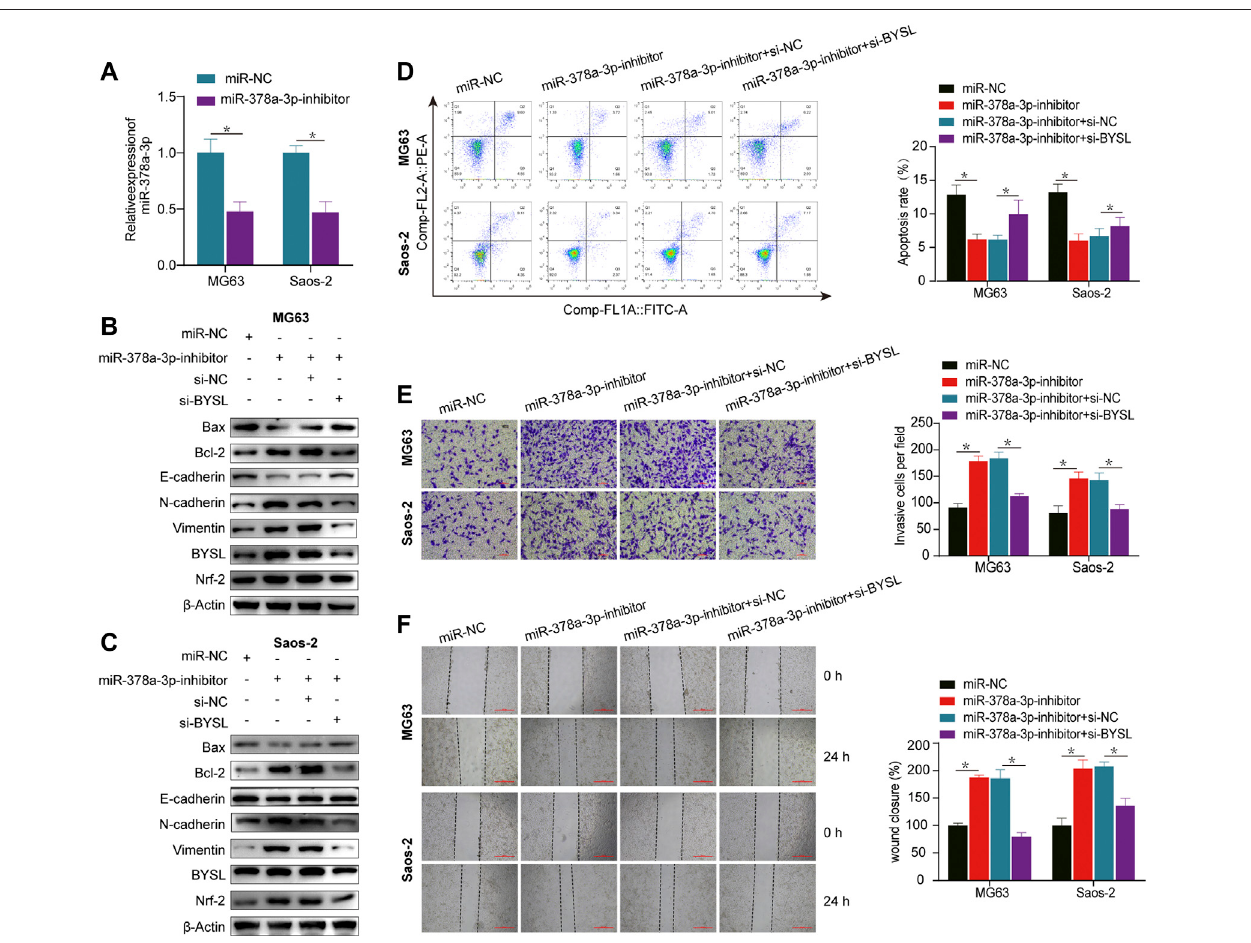
FIGURE 3 | BYSL knockdown partially abolishes miR-378a-3p-mediated osteosarcoma cell epithelial-to-mesenchymal transition (EMT), invasion, migration, and apoptosis under normoxia. (A) MG63 and Saos-2 cells were transfected with control-inhibitor (miR-NC) or miR-378a-3p-inhibitor, and then cultured under normoxic conditions. The RNA level of miR-378a-3p was measured by RT-qPCR. (B,C) MG63 and Saos-2 cells were transfected with control-inhibitor (miR-NC), miR-378a-3p- inhibitor,si-control(si-NC),orsi-BYSL, andthencultured undernormoxicconditions.Theproteinlevels ofBax,Bcl-2,E-cadherin,N-cadherin, vimentin, BYSLand Nrf2weremeasuredbywesternblot. (D) MG63andSaos-2cellsweretransfectedwithcontrol-inhibitor(miR-NC),miR-378a-3p-inhibitor,si-control(si-NC),orsi-BYSL, and then cultured under normoxic conditions. Cell apoptosis was measured by fl ow cytometry. (E) MG63 and Saos-2 cells were transfected with control-inhibitor (miR- NC), miR-378a-3p-inhibitor, si-control (si-NC), or si-BYSL, and then cultured under normoxic conditions. Cell invasion was measured by matrigel invasion assay. Scale bar (cid:1) 100 µm. (F) MG63 and Saos-2 cells were transfected with control-inhibitor (miR-NC), miR-378a-3p-inhibitor, si-control (si-NC), or si-BYSL, and then cultured under normoxic conditions. Cell migration was measured by scratch wound healing assay. Scale bar (cid:1) 500 µm. The data are presented as the mean ± SD. * p <